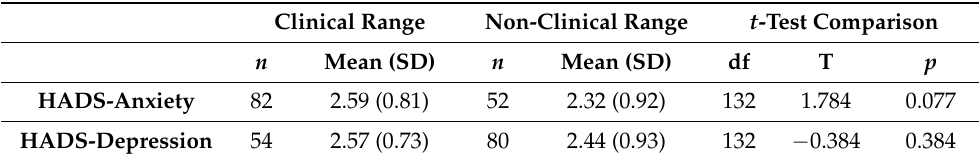
Table 3. T-tests comparing life satisfaction after 18 months of GAHT grouped by caseness of pre- GAHT anxiety and depression (HADS).